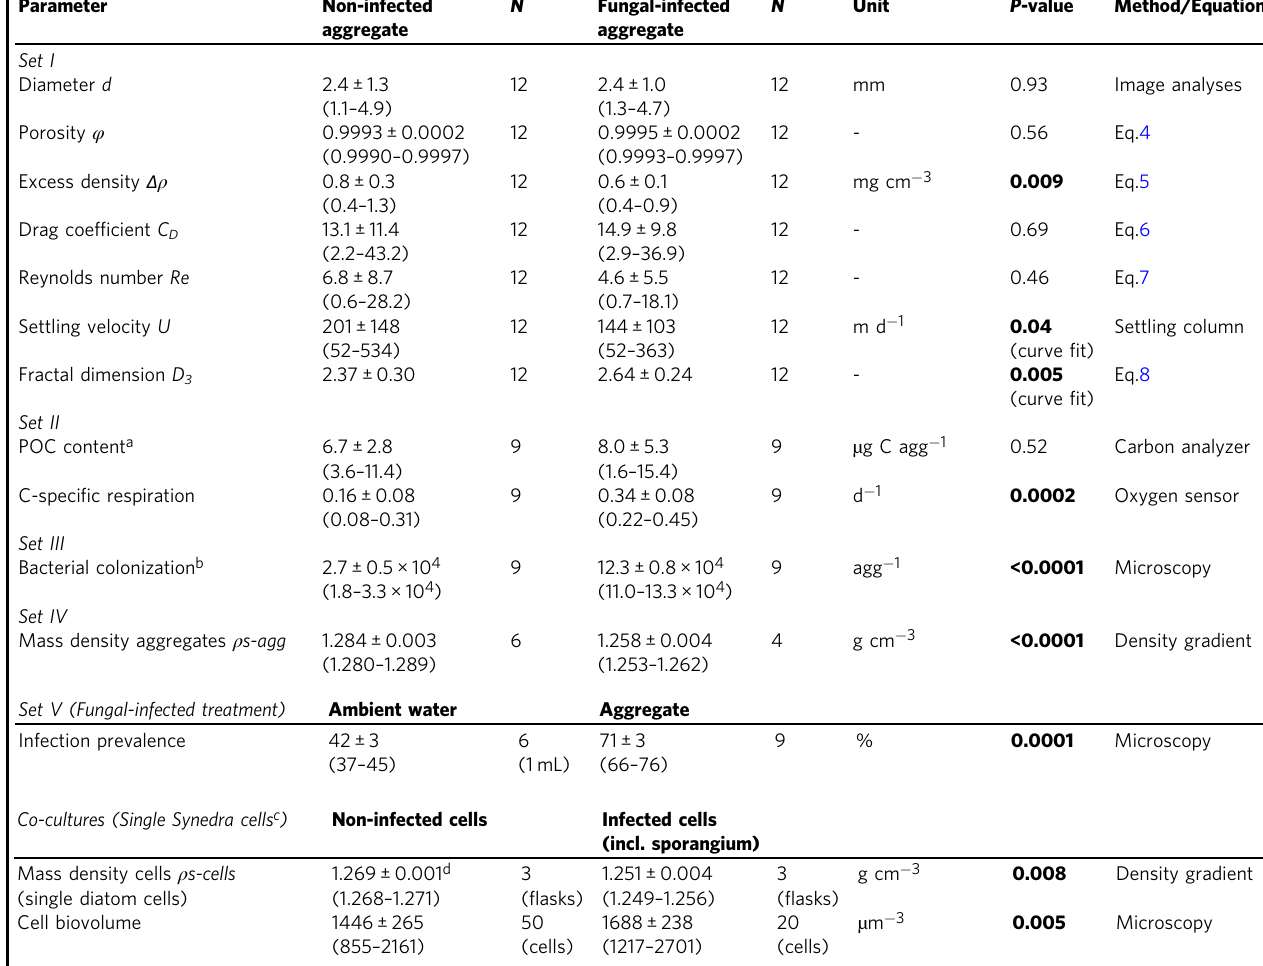
Table 1 Characteristics of single aggregates formed from non-infected and fungal-infected diatom